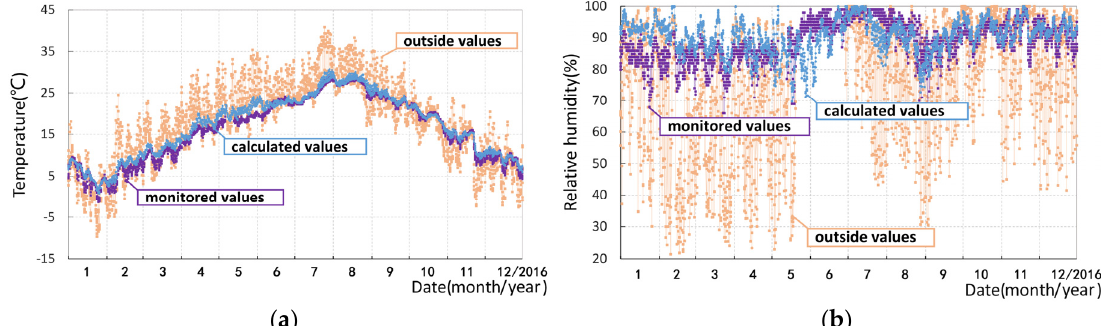
Figure 6. ( a ) Air temperature in the tomb chamber and the outside; ( b ) Relative humidity in the tomb chamber and the outside.